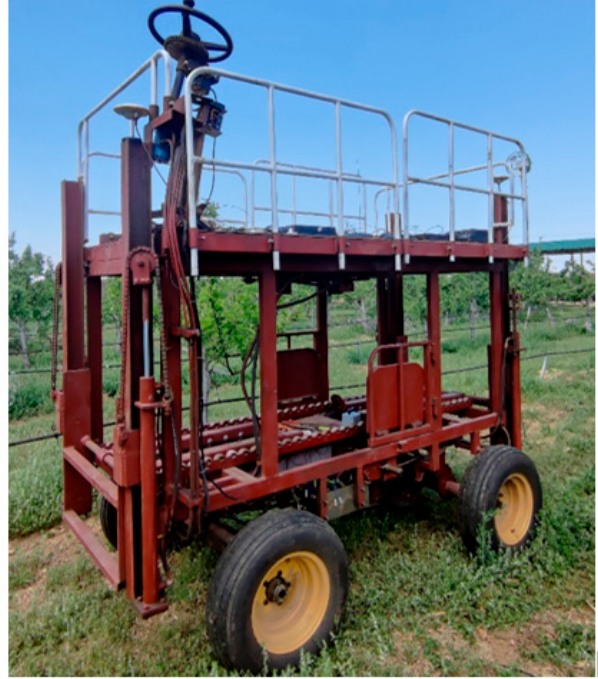
Figure 18. Photo of the fruit-picking platform.